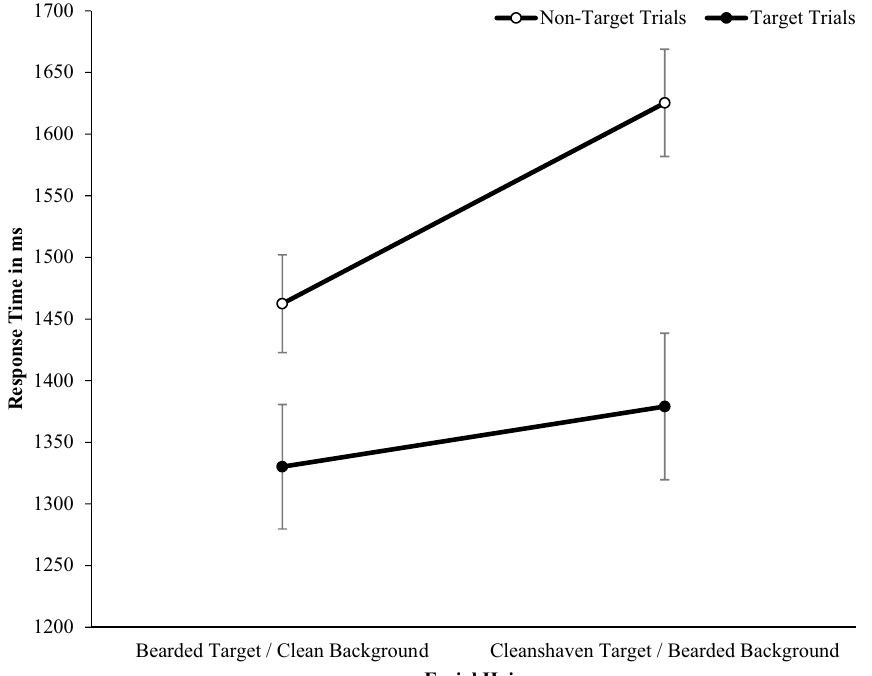
Figure 3. Mean response times for Study 1 (Error bars are ± 1 SEM). The white circles indicate non-target trials, wherein the background does not include a face that is different from the rest (e.g., a clean-shaven background with no bearded faces). The black circles indicate when a face different from the rest in the presence or absence of facial hair was included (i.e., a clean-shaven target in a bearded